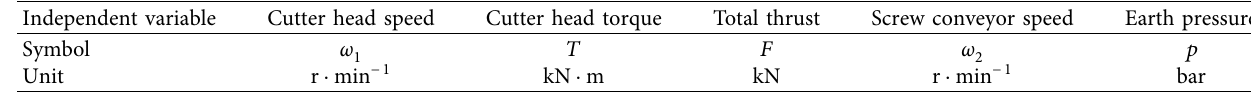
Table 3: Choice of model regression parameters.